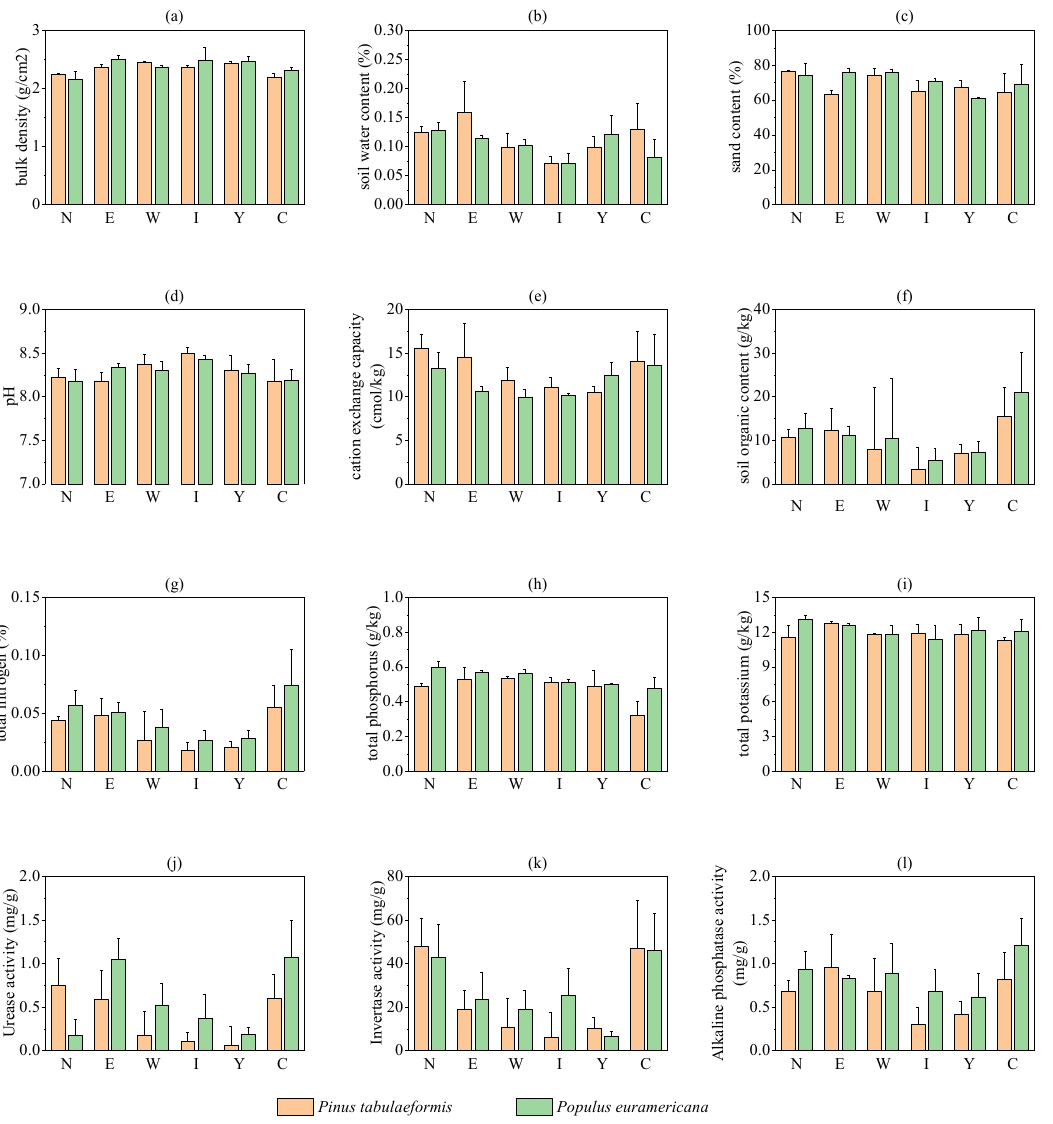
Figure 2. Soil physicochemical properties and enzyme activities. Note: Y is the Yinwang waste dump, I is the inner waste dump, W is the west waste dump, E is the east waste dump, N is the north waste dump, and C is the control site. ( a ) is bulk denisity, ( b ) is soil water content, ( c ) is sand content, ( d ) is PH, ( e ) is cation exchange capacity, ( f ) is soil organic content, ( g ) is total nitrogen, ( h ) is total phosphorus, ( i ) is total potassium, ( j ) is urease activity, ( k ) is invertase activity, ( l ) is alkaline phosphatase activity.